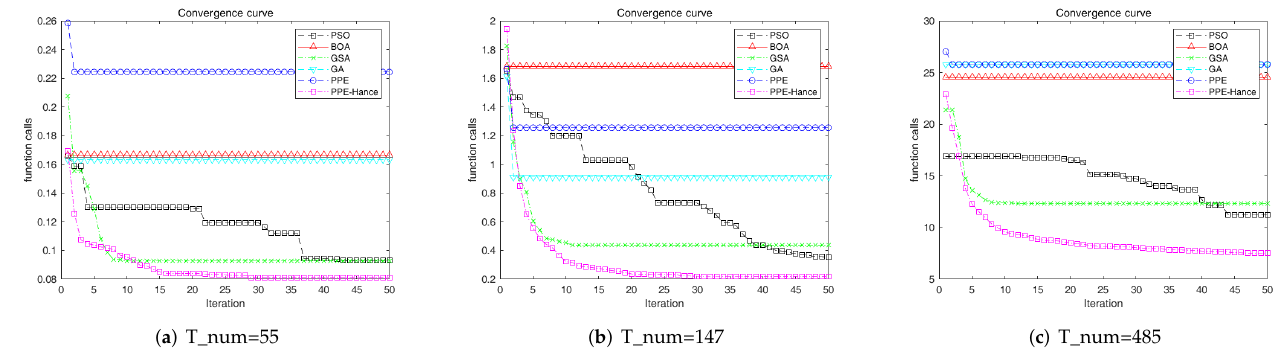
Figure 3. The convergence comparison of different numbers of tasks in heterogeneous Environment 1.